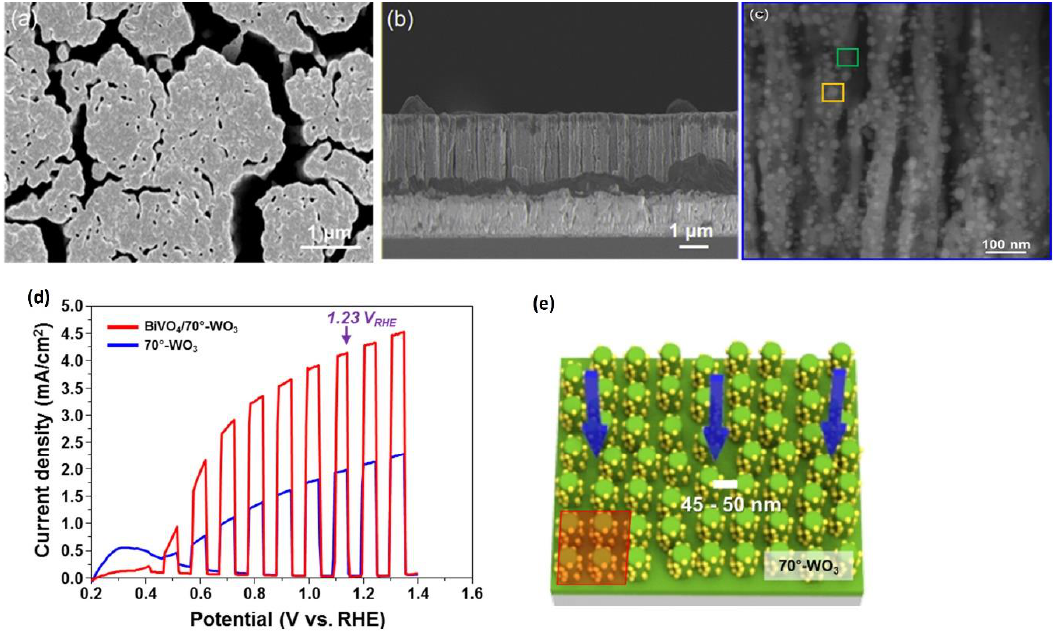
Figure 9. ( a , b ) Top and cross-section SEM images of the optimum BiVO4 / 70 ◦ -WO 3 nanorods; ( c ) expanded image of BiVO 4 / WO 3 nanorods, ( d ) enhancement of photocurrent density of BiVO 4 / WO 3 nanorods (70 ◦ ) nanorods; ( e ) schematic illustration of BiVO 4 / WO 3 nanorods. Reproduced from [65], with permission from Elsevier,